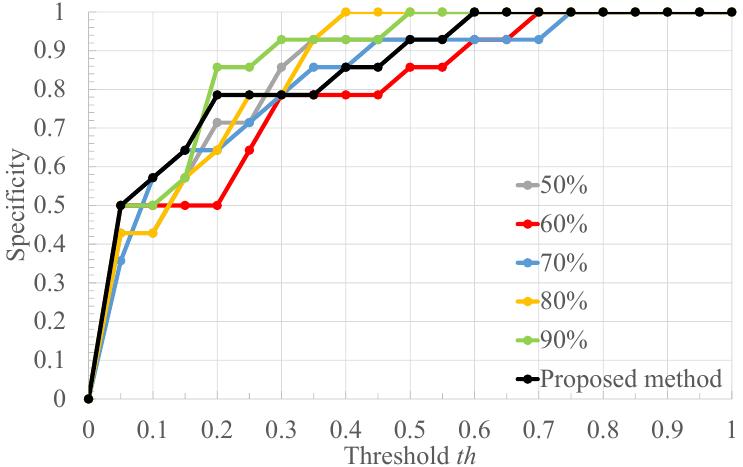
Figure 14. The specificity of the method based on three-value classification (the percentage classified as moderate RRI = 50, 60, 70, 80, 90%) and the proposed method.